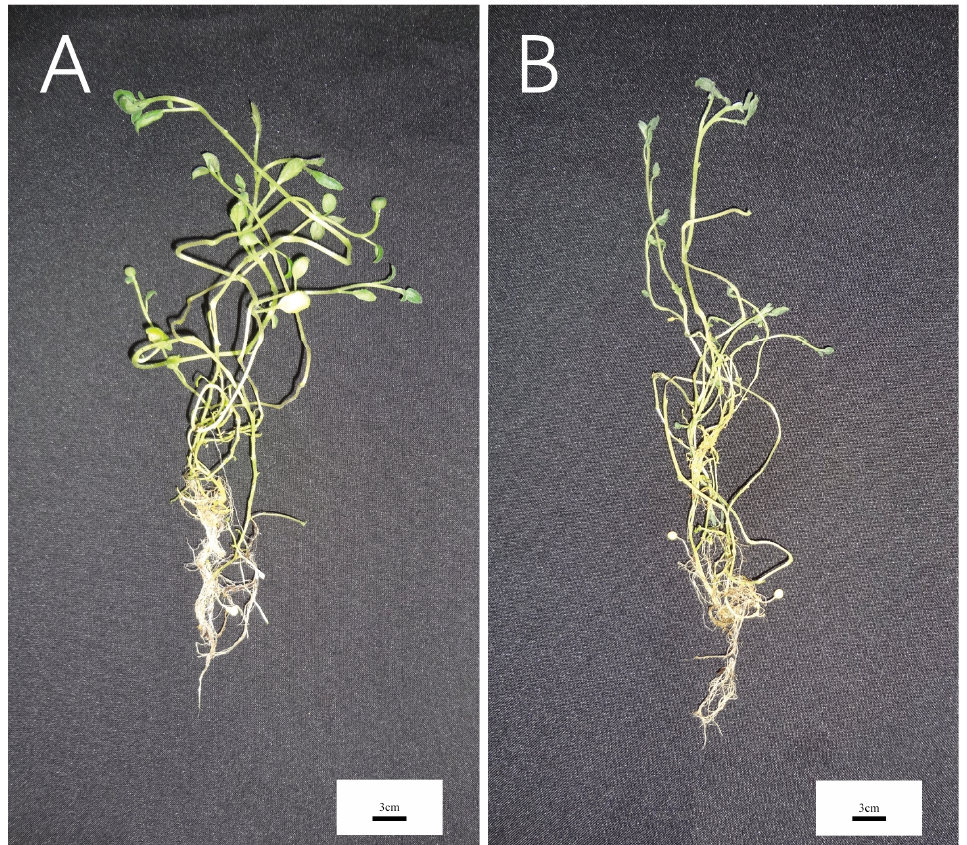
Figure 11. Potato seedlings treated with normal watering and drought stress for 20 days. ( A ) Desiree seedlings of potato varieties treated with normal watering for 20 days. ( B ) Desiree seedlings of potato variety treated for 20 days under drought stress.